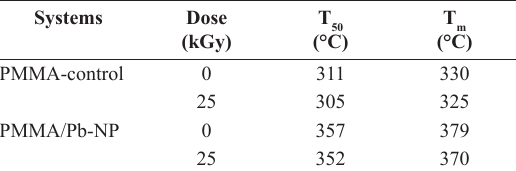
Table 4. TGA results for PMMA and PMMA/PbS-NP films. Systems Dose